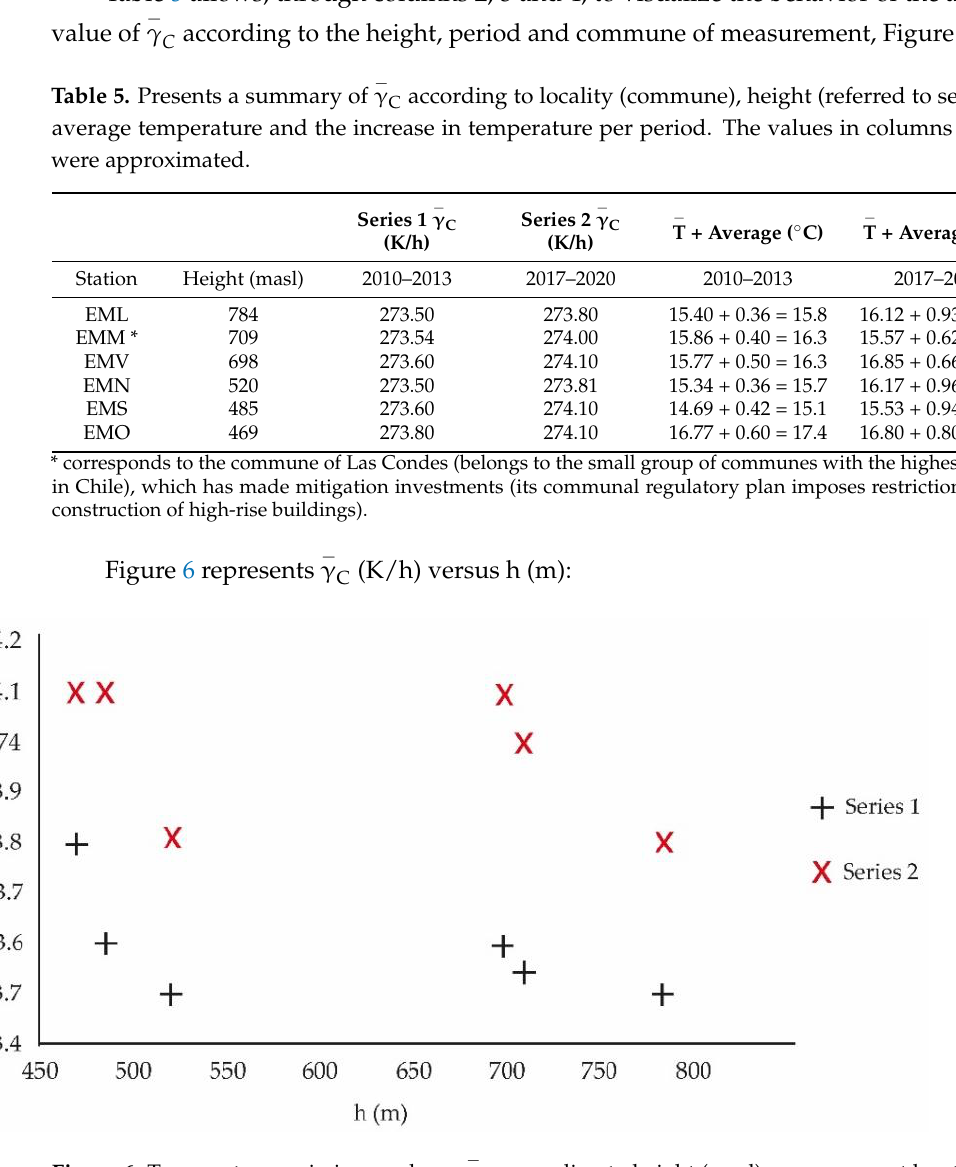
C , according to height (masl), measurement location